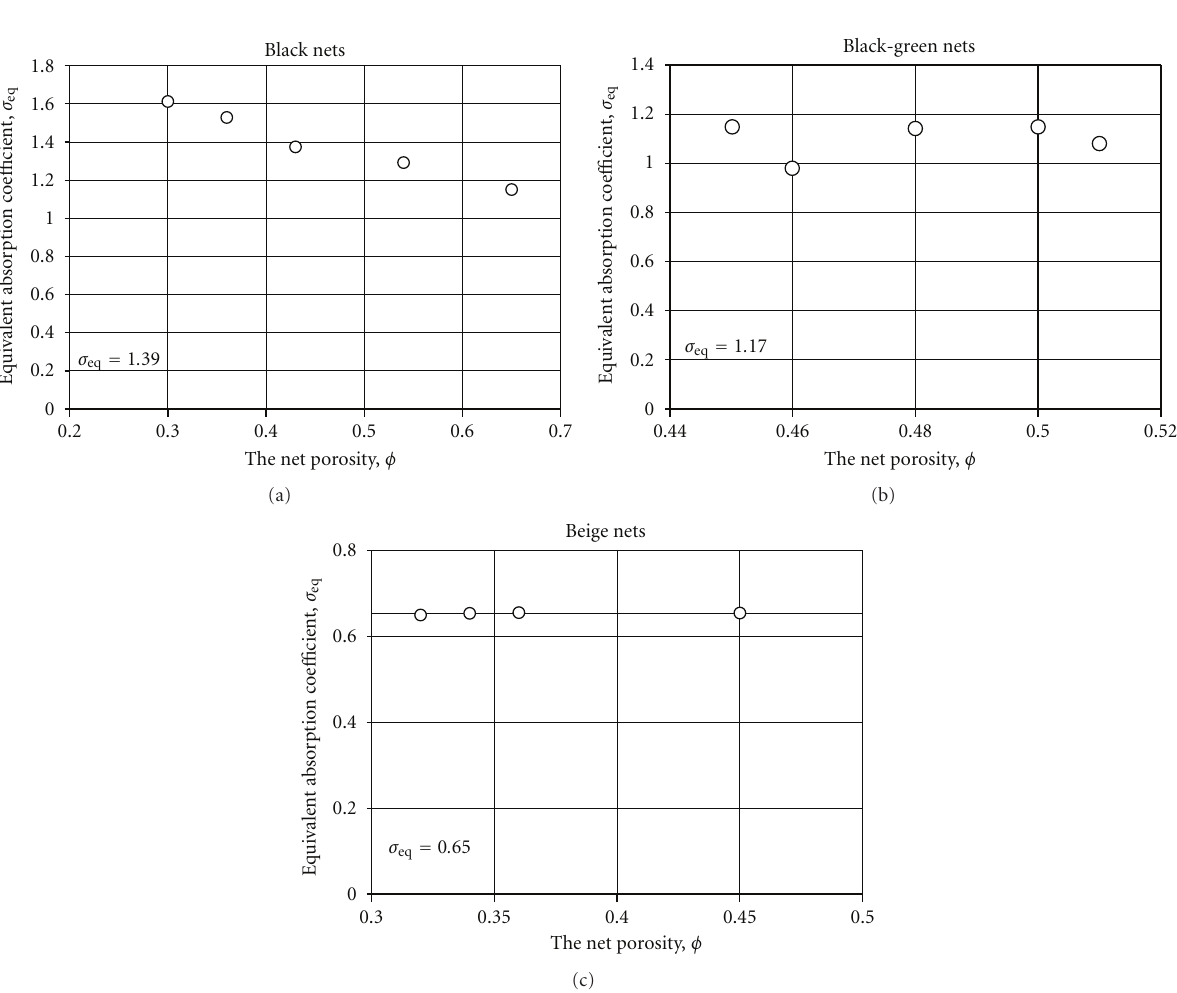
Figure 4: The equivalent absorption coe ffi cient ( σ eq ) as a ff ected by the porosity of the tested nets: (a) is for the black group, (b) for the black-green group, and (c) for the beige